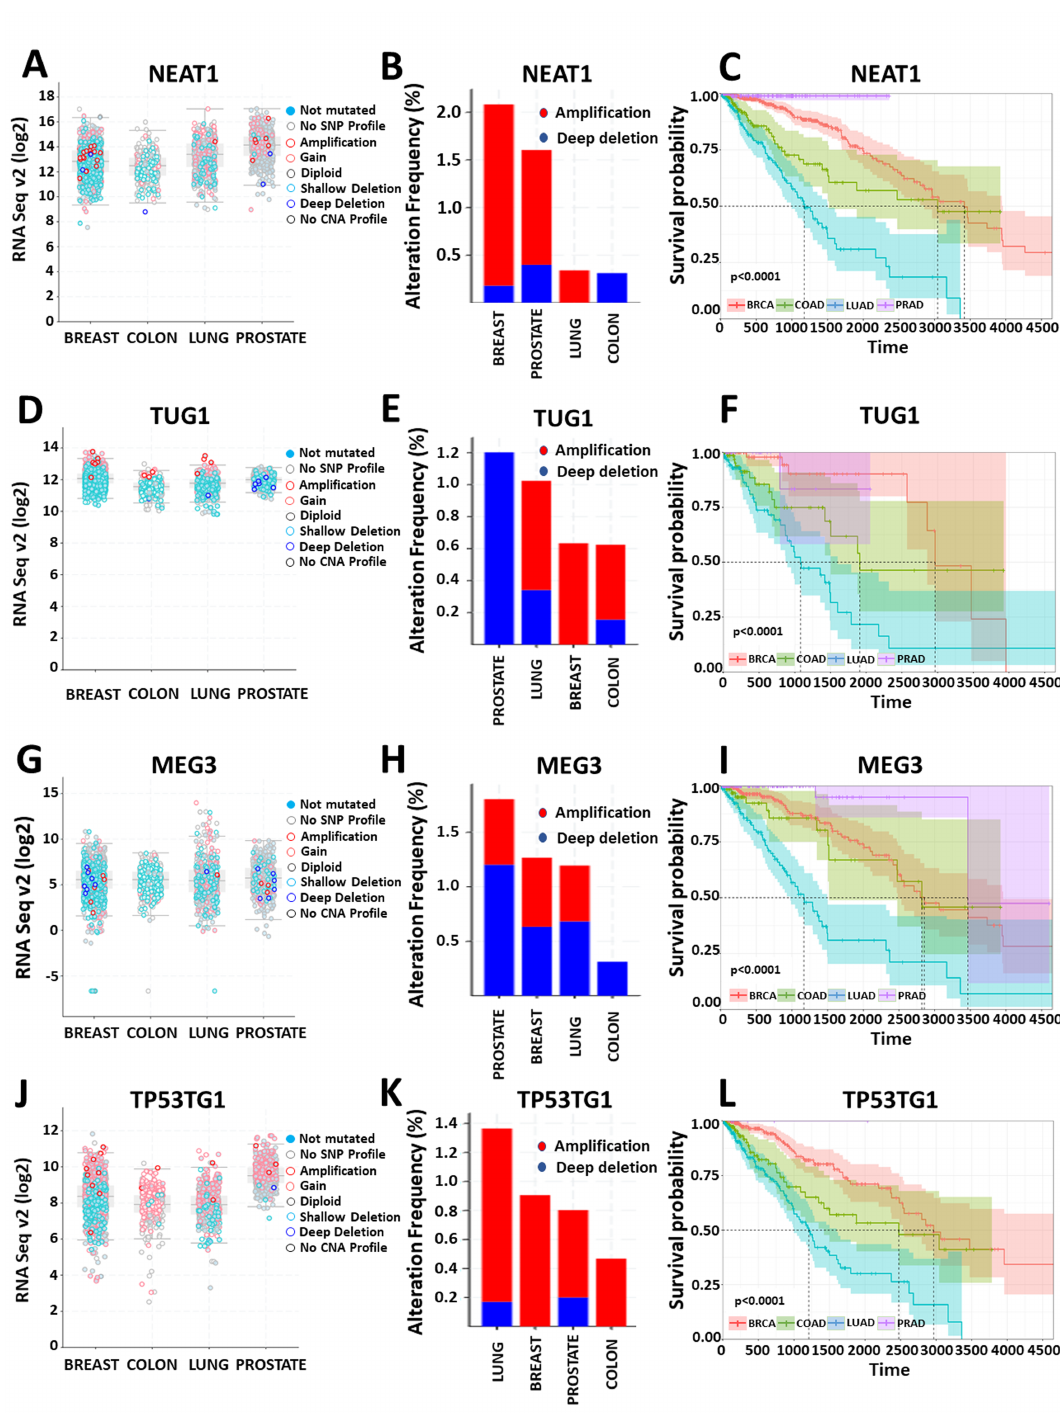
Figure 2. Expression, genetic alteration, and survival analysis of selected lncRNA epigenetic regulators in the most frequent types of cancer based on TCGA (The Cancer Genome Atlas) data. Left panels ( A,D,G,J ) correlate lncRNA gene expression with copy number variation across cancer types. Middle panels ( B,E,H,K ) demonstrate amplification and / or deep deletion percentage of each lncRNA gene among patients for each cancer type. Right panels ( C,F,I,L ) demonstrate average impact on survival time for each cancer type, based on intermediate lncRNA expression (patient stratification cut-o ff s: > Q1 and < Q3). Dashed lines in Kaplan–Meier plots represent median survival time, p -values correspond to statistical significance of survival di ff erence between all tumor types for each lncRNA. ( A–C ) Expression, genetic amplification / loss, and survival analysis of NEAT1. Gene copies of this lncRNA are increased in breast and prostate compared with the other cancer types. ( D–F ) Expression, genetic amplification /